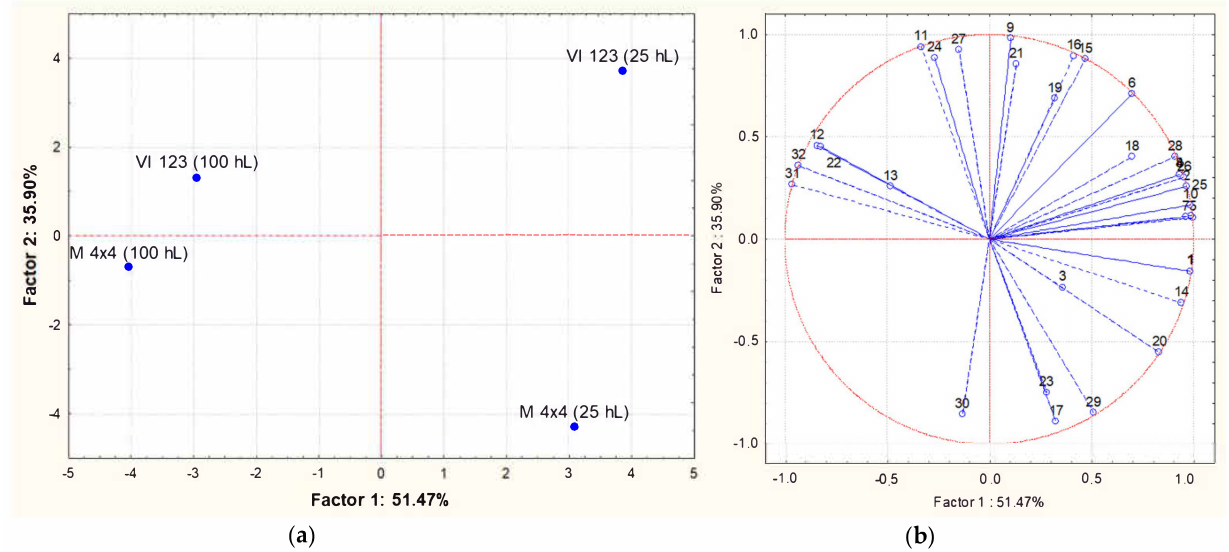
Figure 7. Principal Component Analysis carried out on volatile compounds content in wines obtained inoculating the indigenous strain VI 123 and the commercial strain BM4 × 4 in 25 or 100 hL of grape must. ( a ): similarity map determined by Principal Component (Factor) 1 and 2; ( b ): projection of the variables on the factor plane. Variables: (1) Ethyl